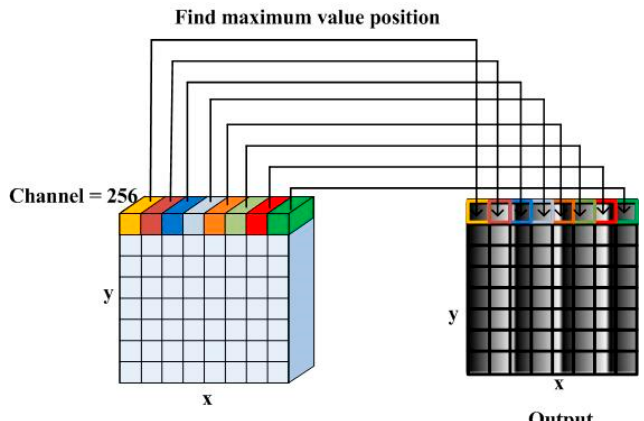
Figure 4. Output schematic.